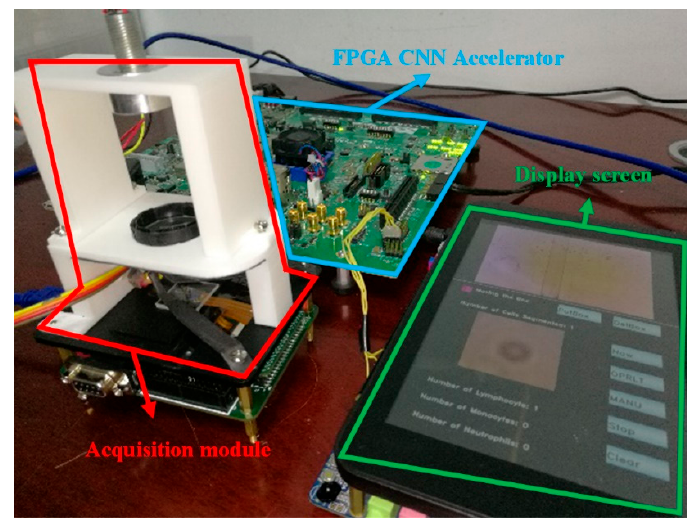
Figure 14. Mobile CNN microfluidic blood ‐ acquisition and analysis prototype system.